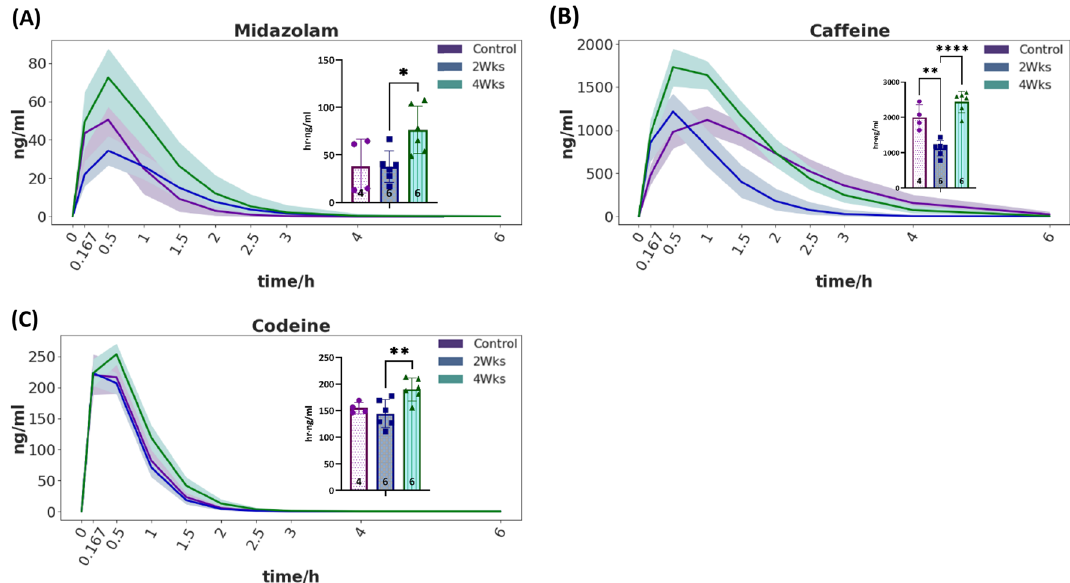
Figure 6. Drug elimination curves of the test drugs and metabolites and corresponding AUC. ( A ) Midazolam; ( B ) Caffeine; ( C ) Codeine; *significance level < 0.05, **significance level < 0.01, ***significance level < 0.001, ****significance level < 0.0001, sample size of each group displayed in the bottom of the bar. Solid lines are mean, shaded areas correspond to the 95% credibility interval from the Bayesian